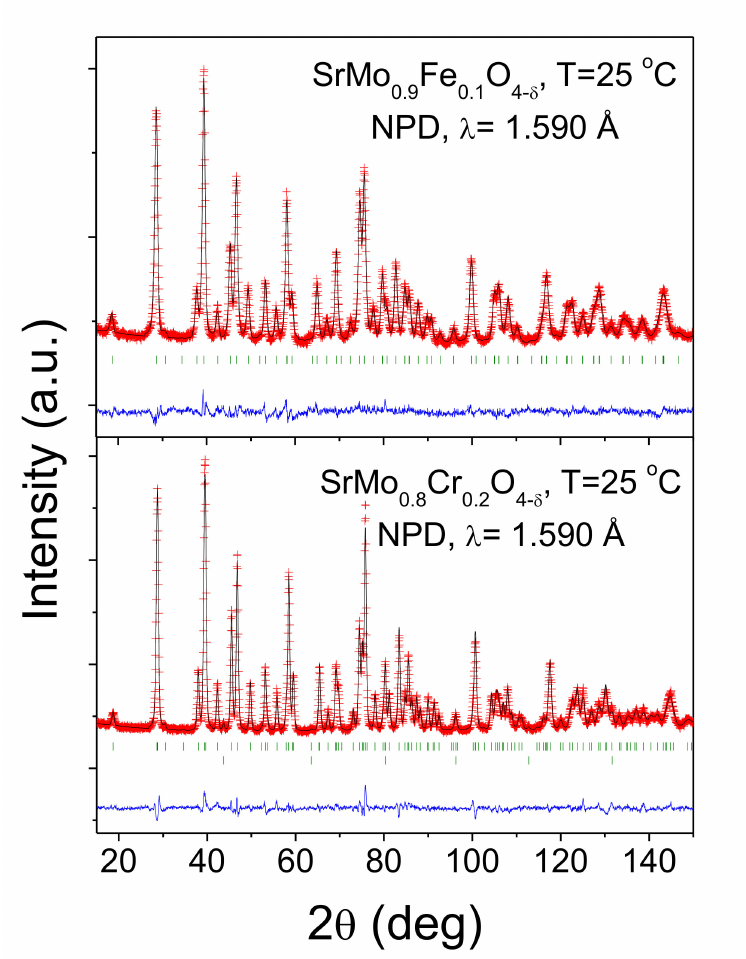
Figure 3. Observed (crosses), calculated (full line), and di ff erence (at the bottom) neutron powder di ff raction (NPD) profiles for SrMo 0.9 Fe 0.1 O 4 − δ and SrMo 0.8 Cr 0.2 O 4 − δ at 25 ◦ C, refined in the tetragonal I4 1 / a space group. The vertical markers correspond to the allowed Bragg reflections. The second series of Bragg reflections correspond to vanadium from the sample